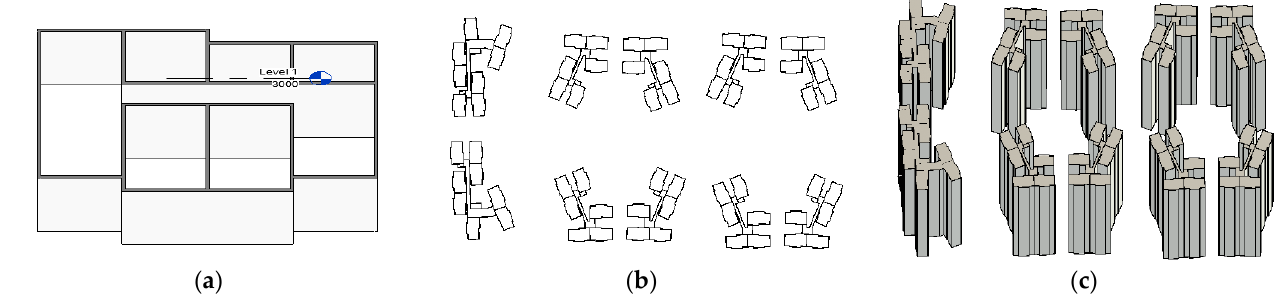
Figure 4. Modular residential buildings. ( a ) Volumetric unit, ( b ) Typical floor plan, ( c ) 3D view.